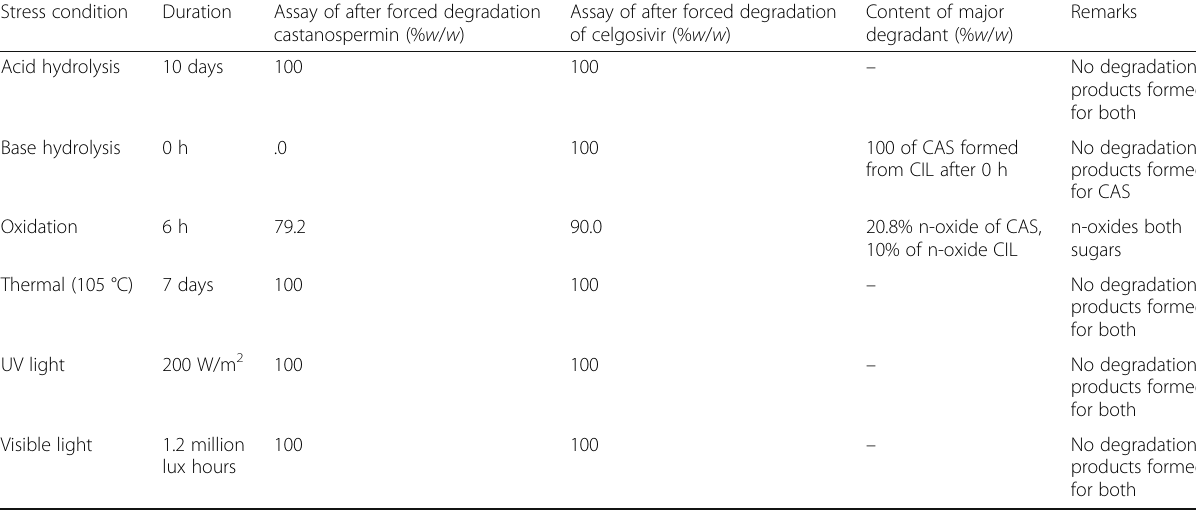
Table 3 Summary of forced degradation results Stress